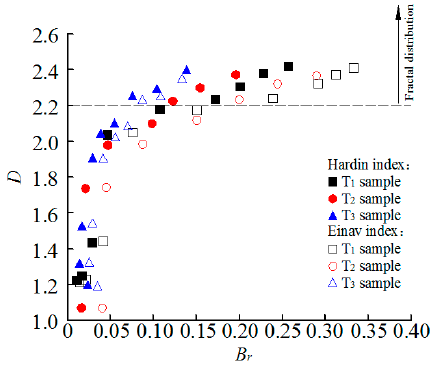
Figure 8. Influence of relative breakage on fractal dimension.